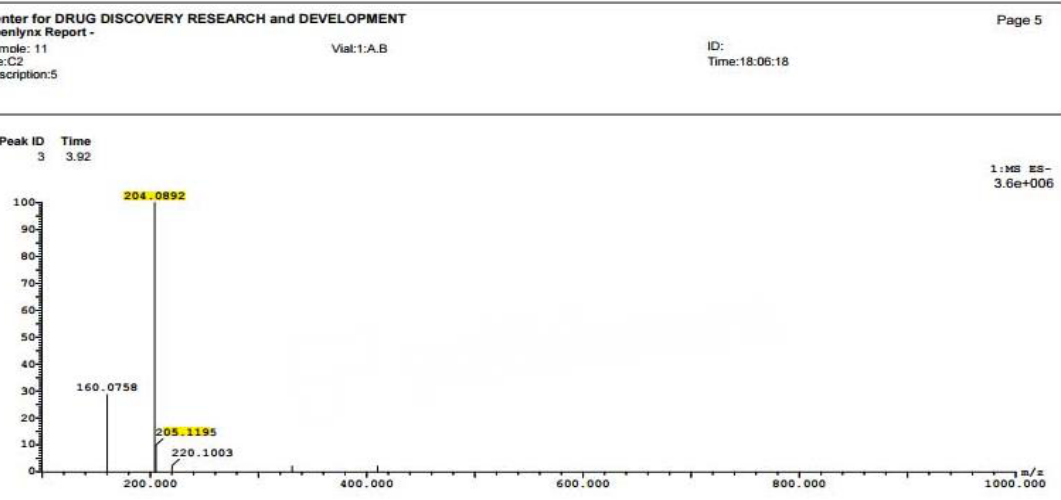
Figure 16. First mass for isolated AS1 compound peak 3 at retention time 3.92 min with major molecular ion [M-H] -